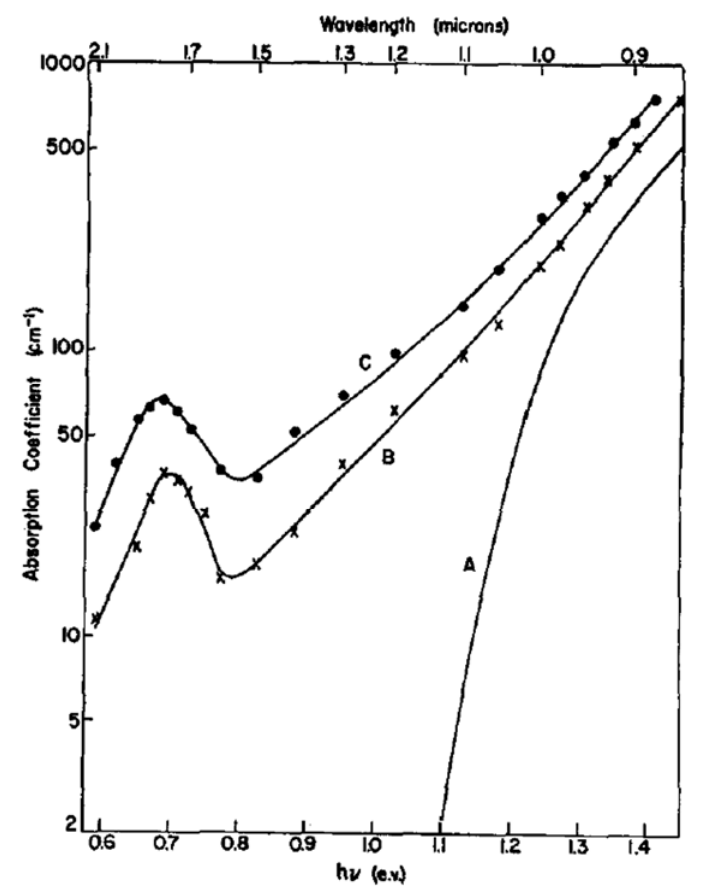
Figure 1. Absorption spectrum of deuteron-irradiated silicon. A: normal silicon; B and C: after successive deuteron irradiations [24]. Copyright 1959, American Institute of